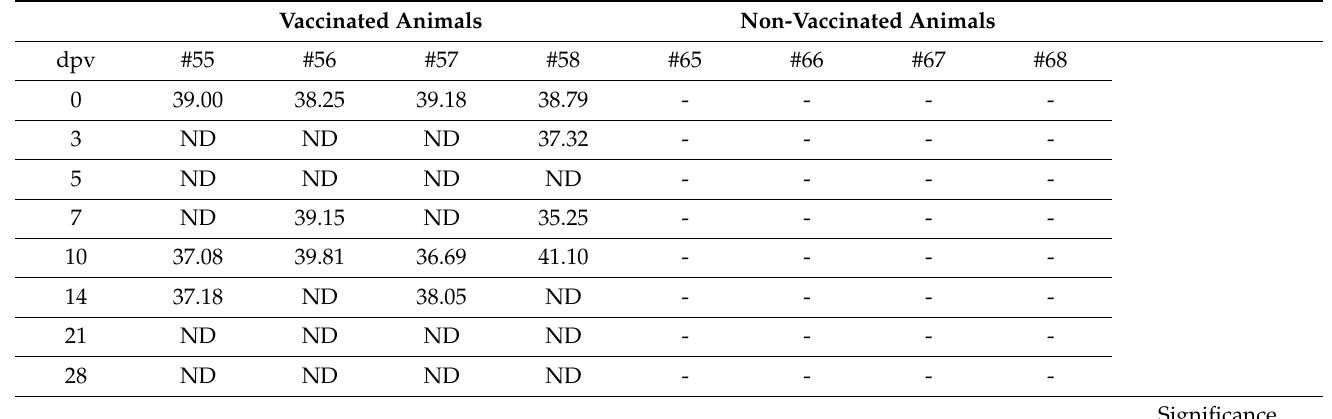
Table 2. Viremia detected by qPCR in EDTA blood samples in vaccinated (#55–58) and non-vaccinated (#65–68) animals at the indicated days post vaccination (dpv) and days post challenge